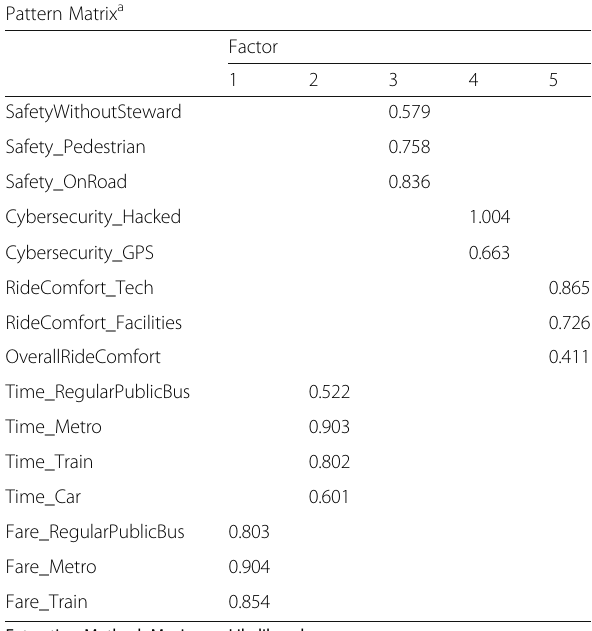
Table 4 Pattern matrix of the service quality attribute perceptions included as the indicators for the latent variables in structural equation model